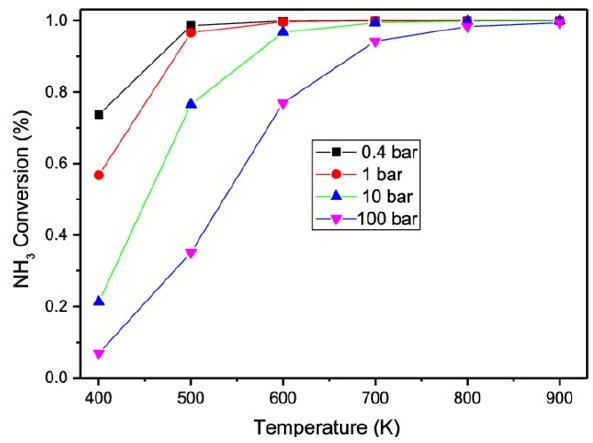
Figure 19. Ammonia conversion association with reaction temperature. Reprinted with permission [93].